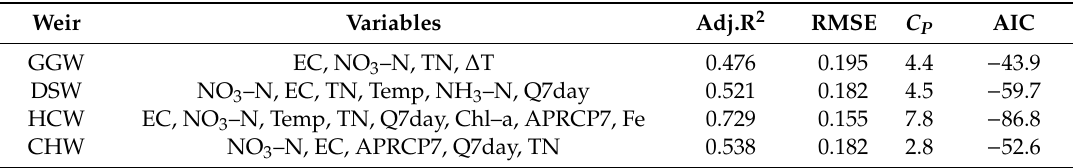
Table 2. Subset of regression variables that best-matched performance criterion in step-wise multiple linear regression (SMLR) analysis for Gangjeong Goryeong weir (GGW), Dalseong weir (DSW), Hapcheon Changnyeong weir (HCW), and Changnyeong Haman weir (CHW). Note: see the main text for definitions of abbreviated variables.